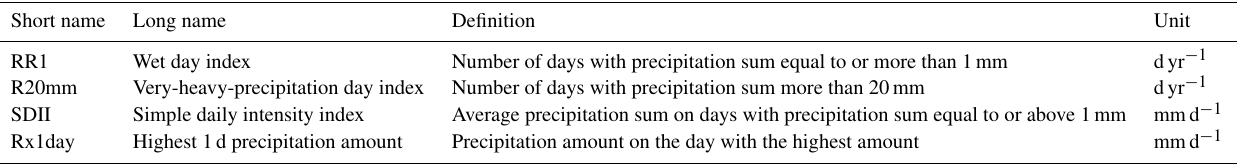
Table 3. Definitions of